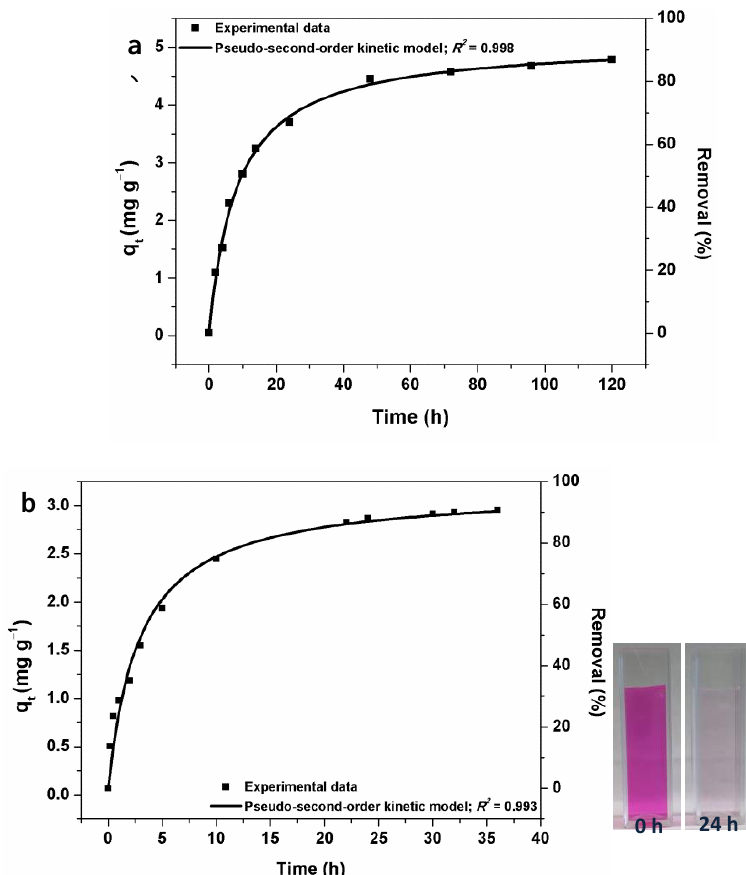
Figure 2. Adsorption capacity versus time, and the nonlinear pseudo-second-order fitting for the adsorption of As(III) ( a ); and Rhodamine B ( b ) on MIL-100(Fe)@BC nanocomposite, respectively. The inset shows a photograph of the Rhodamine B aqueous solutions before and after the adsorption process.